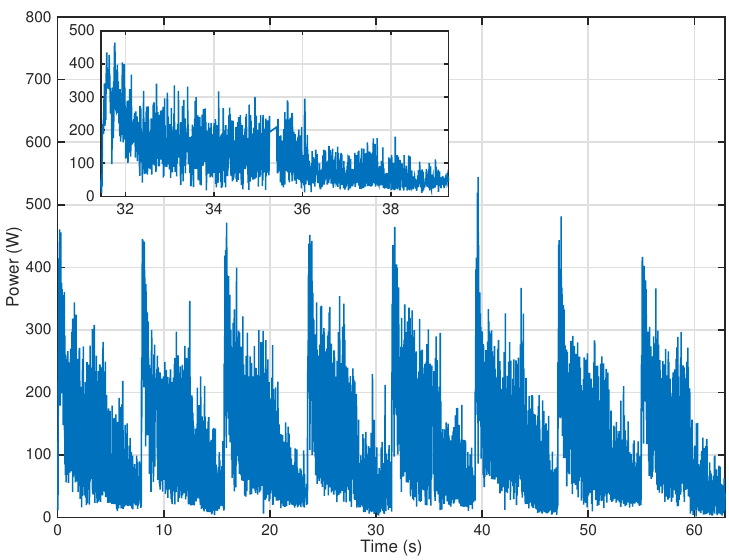
Figure 3. Total power consumption of the robot as a function of time ( v max = 0.5